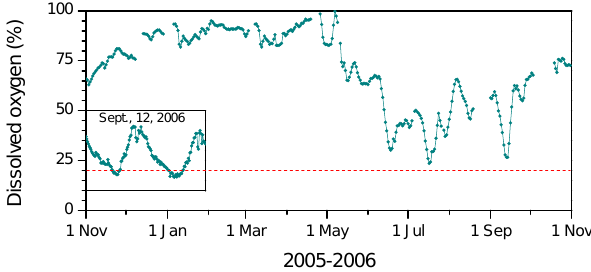
Fig. 5. Temporal evolution of daily-average dissolved oxygen satu- ration (% of saturation), from November 2005 to October 2006, at the station Bordeaux. The inset corresponds to a zoom of the curve centered on the 12 September 2006, showing the detailed data (ev- ery 10min); the Y scale is the same as the one of the main graph; the dashed line underlines dissolved oxygen saturation of